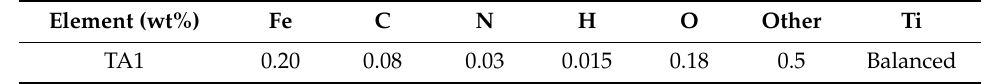
Table 1. The chemical composition (wt%) of the TA1. Table 2. The chemical composition (wt%) of the